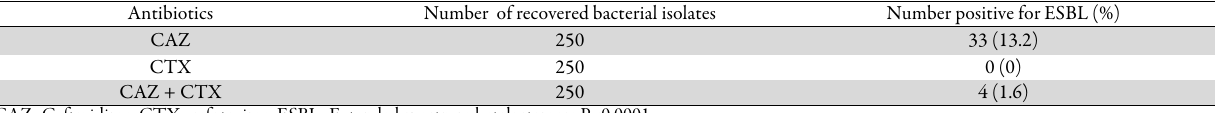
Table 1. Type of ESBL-production by ESBL-producing isolates recovered from cattle feces Antibiotics Number of recovered bacterial isolates